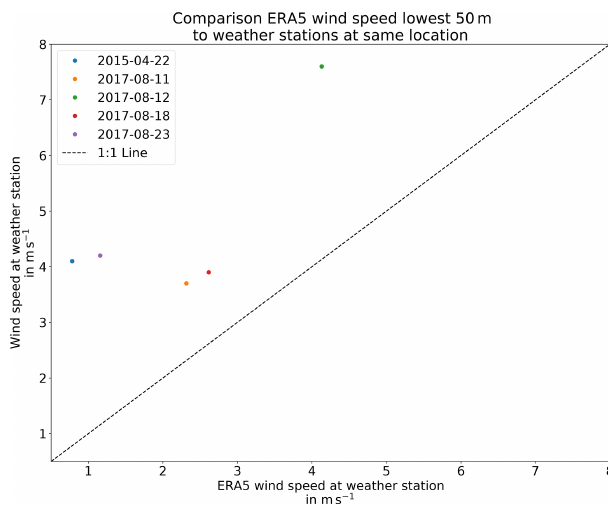
Figure A1. Comparison between wind speed averaged over the low- est 50m above ground for ERA5 data and collocated wind sta- tion data. ERA5 data significantly underestimated the wind speed present at a given